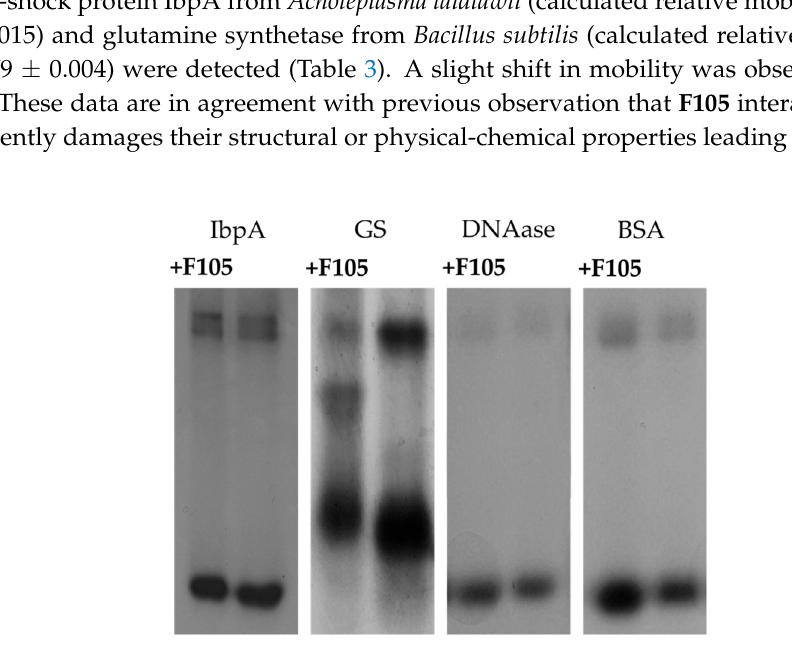
Table 3. Properties of proteins.